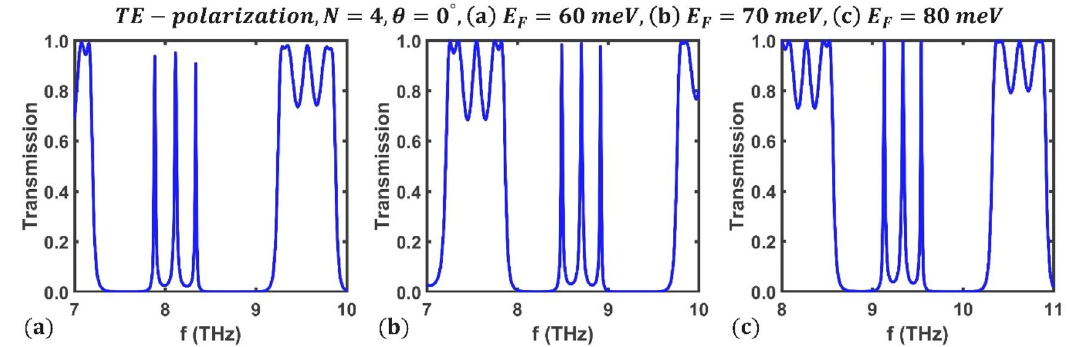
Figure 3. Transmission spectrum of the third-order F-1D PhC under normal incidence condition for TE polarization corresponding to different Fermi energies, ( a ) E F = 60 meV, ( b ) E F = 70 meV, and ( c ) E F = 80